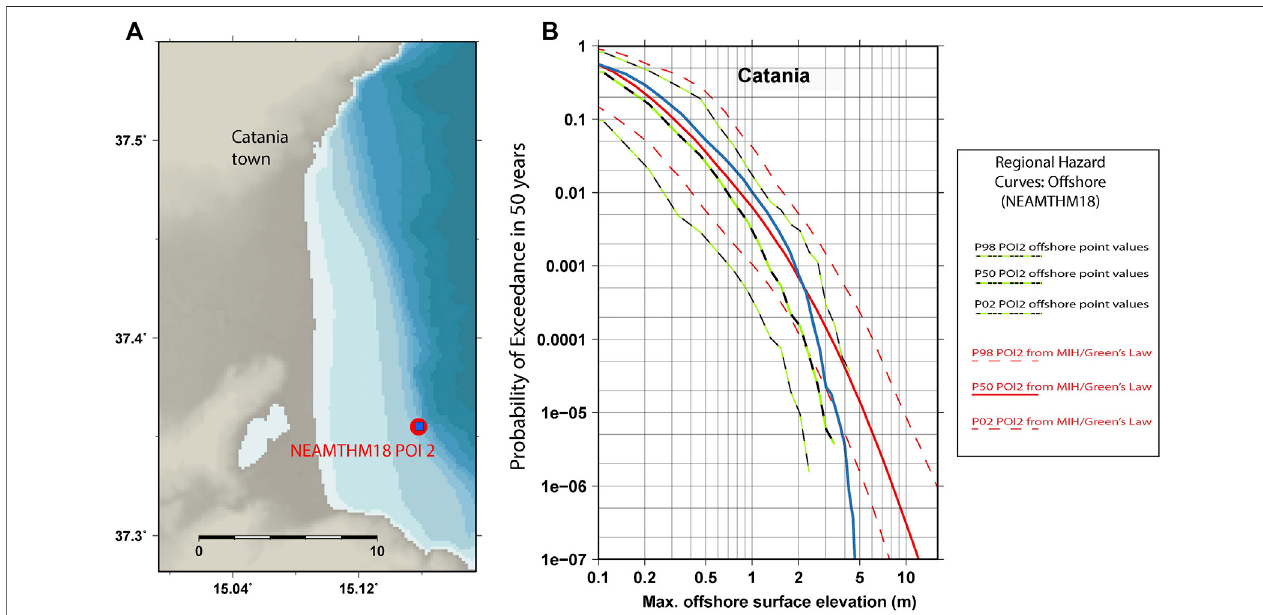
FIGURE 6 | Comparison of offshore PoE curves for the location 37.355 o N 15.158 o E (50 m depth). Panel (A) shows the location of this PoI with respect to the coastlineand panel (B) displaysthenewmean offshorehazard curve (blue), the second, 50th,and 98th percentiles ofoffshore hazardestimated fromthe NEAMTHM18 MIH curves using Green ’ s Law (red), and the corresponding offshore PoE curves calculated from the offshore point values (black/green).